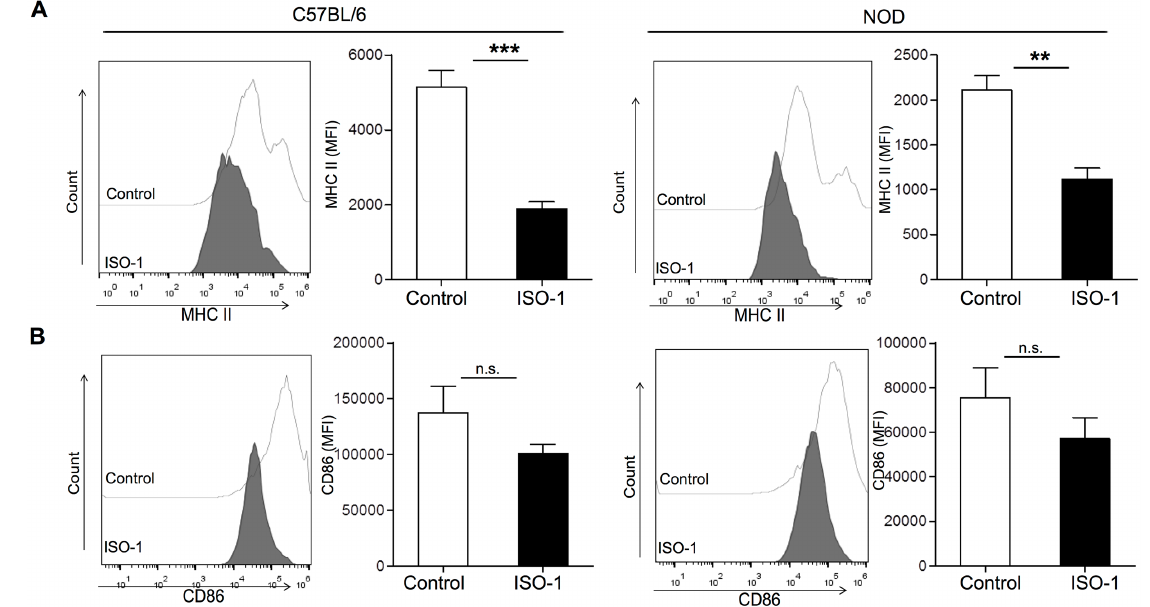
Fig 4. ISO-1 counteracts the activation-induced expression of MHC class II on control and NOD macrophages. (A) Surface moleculeexpressionas analyzedby flow cytometry. Macrophages from either control or NOD mice were cultured in the presenceof ISO-1 (20 μ M) (dark/black) or vehicle control (light/white), followedby overnightstimulationwith or without LPS/IFN- γ before stainingfor surface moleculesinvolvedin antigenpresentationsuch as MHC class II (A; top row) and the co-stimulatory moleculeCD86 (B; bottom row). Analysis was performed on singlet-, viable-,F4/80 + CD11b + cells. The mean fluorescence intensity (MFI) is depicted as histogramoverlays (left) or bar graphs(right) (n = 4–5). The y-axis indicatesthe number of cells analyzed.Values represent the means ± SEM ( * , p < 0.05; ** , p < 0.01; *** p (cid:20) 0.005).